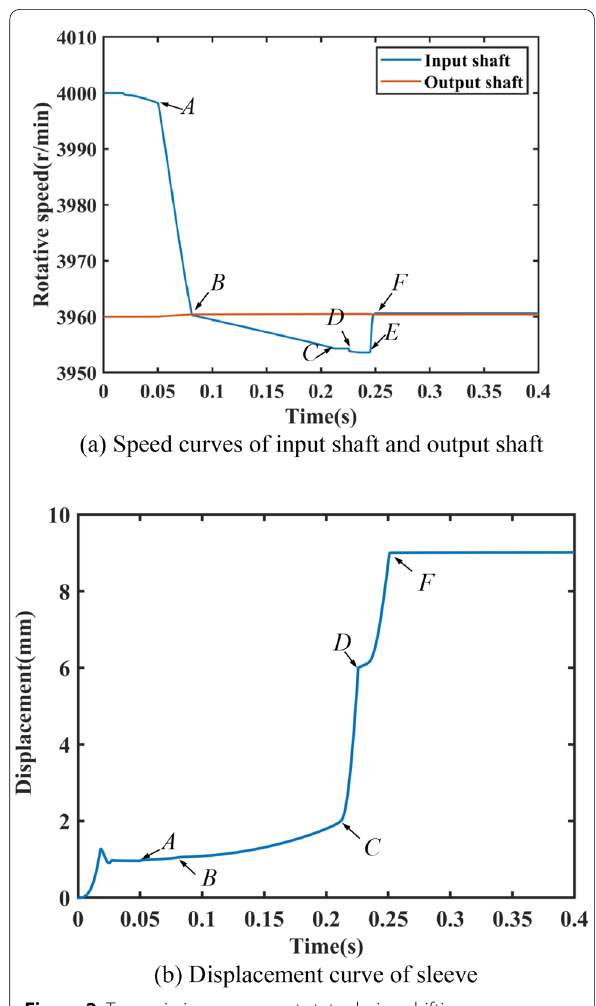
Figure 2 Transmission movement state during